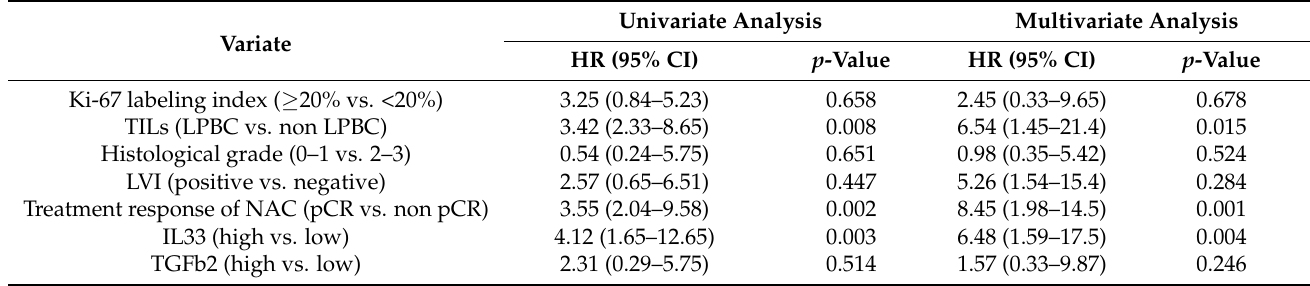
Table 3. Univariate and multivariate analyses for overall survival in TNBC.